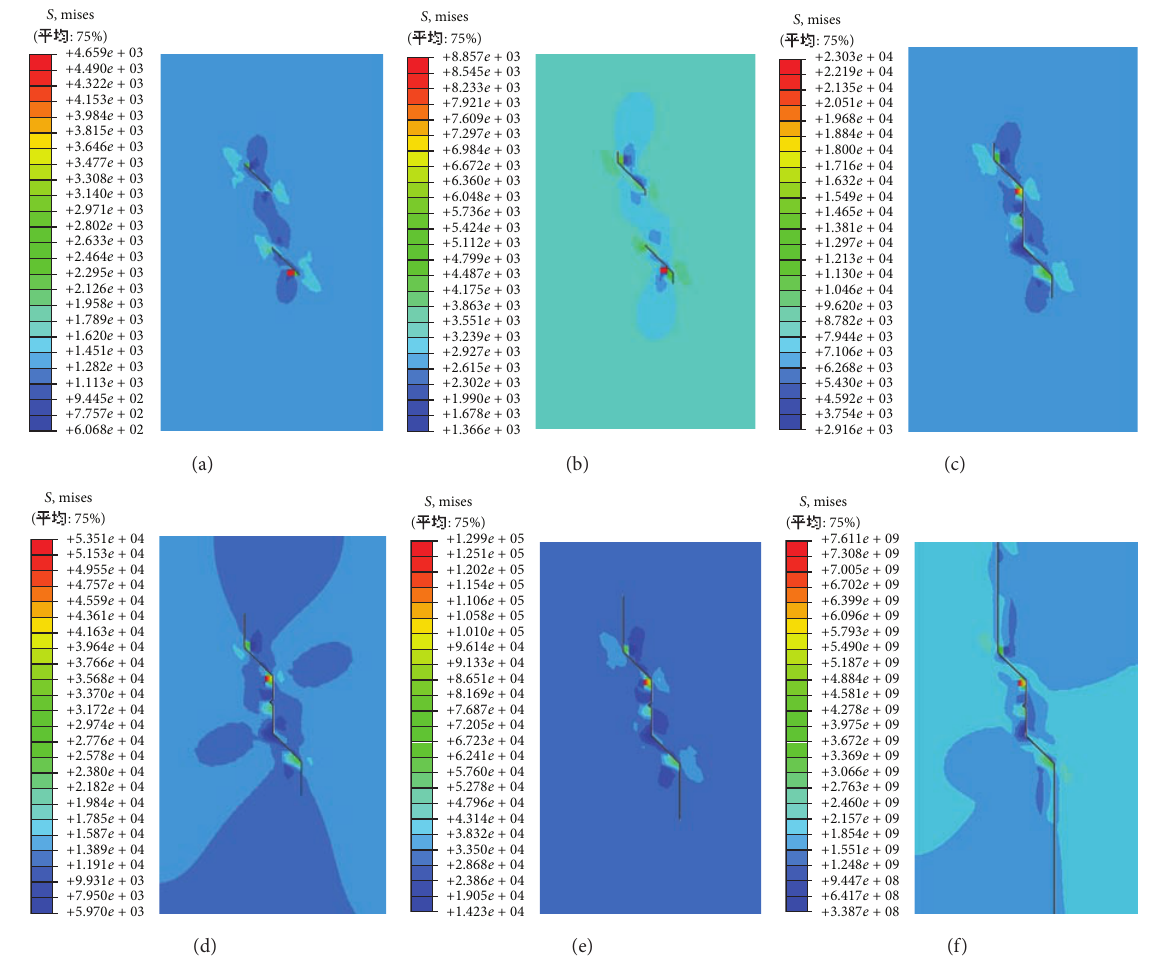
Figure 8: Crack propagated of rock sample under compression simulated by